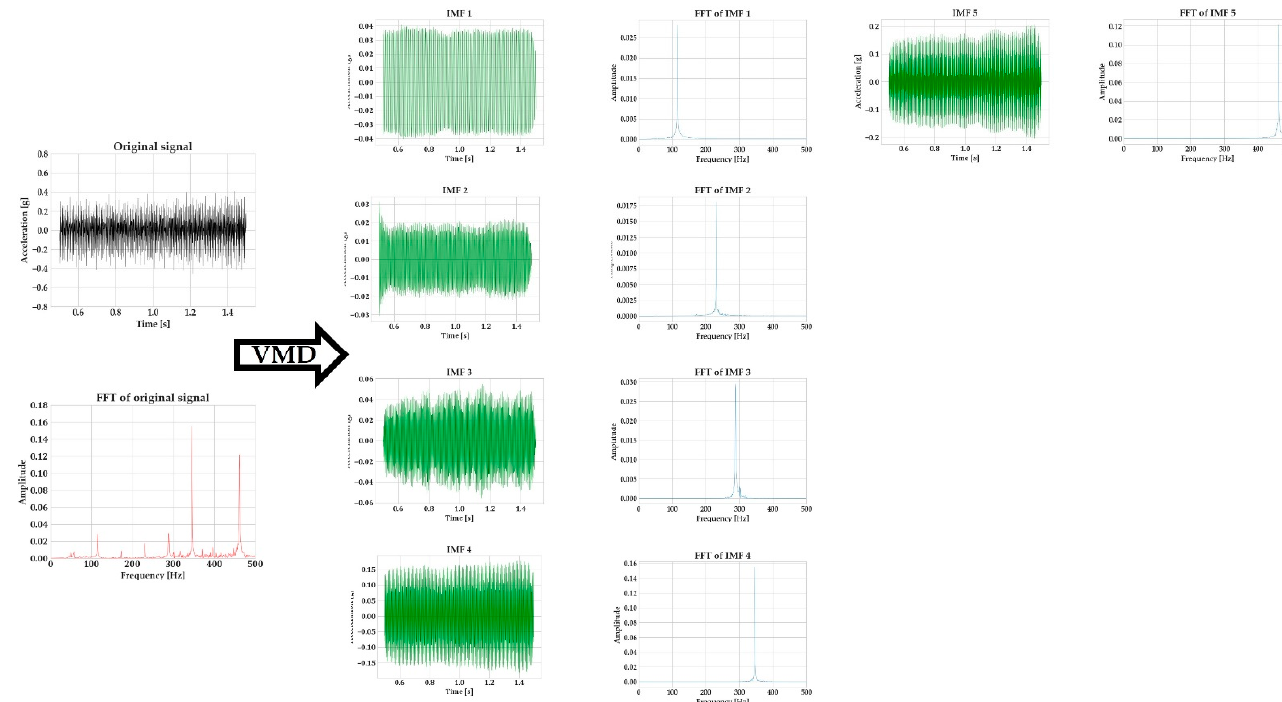
Figure 11. Decomposition of the milling vibration signal generated by the Kistler sensor with VMD.